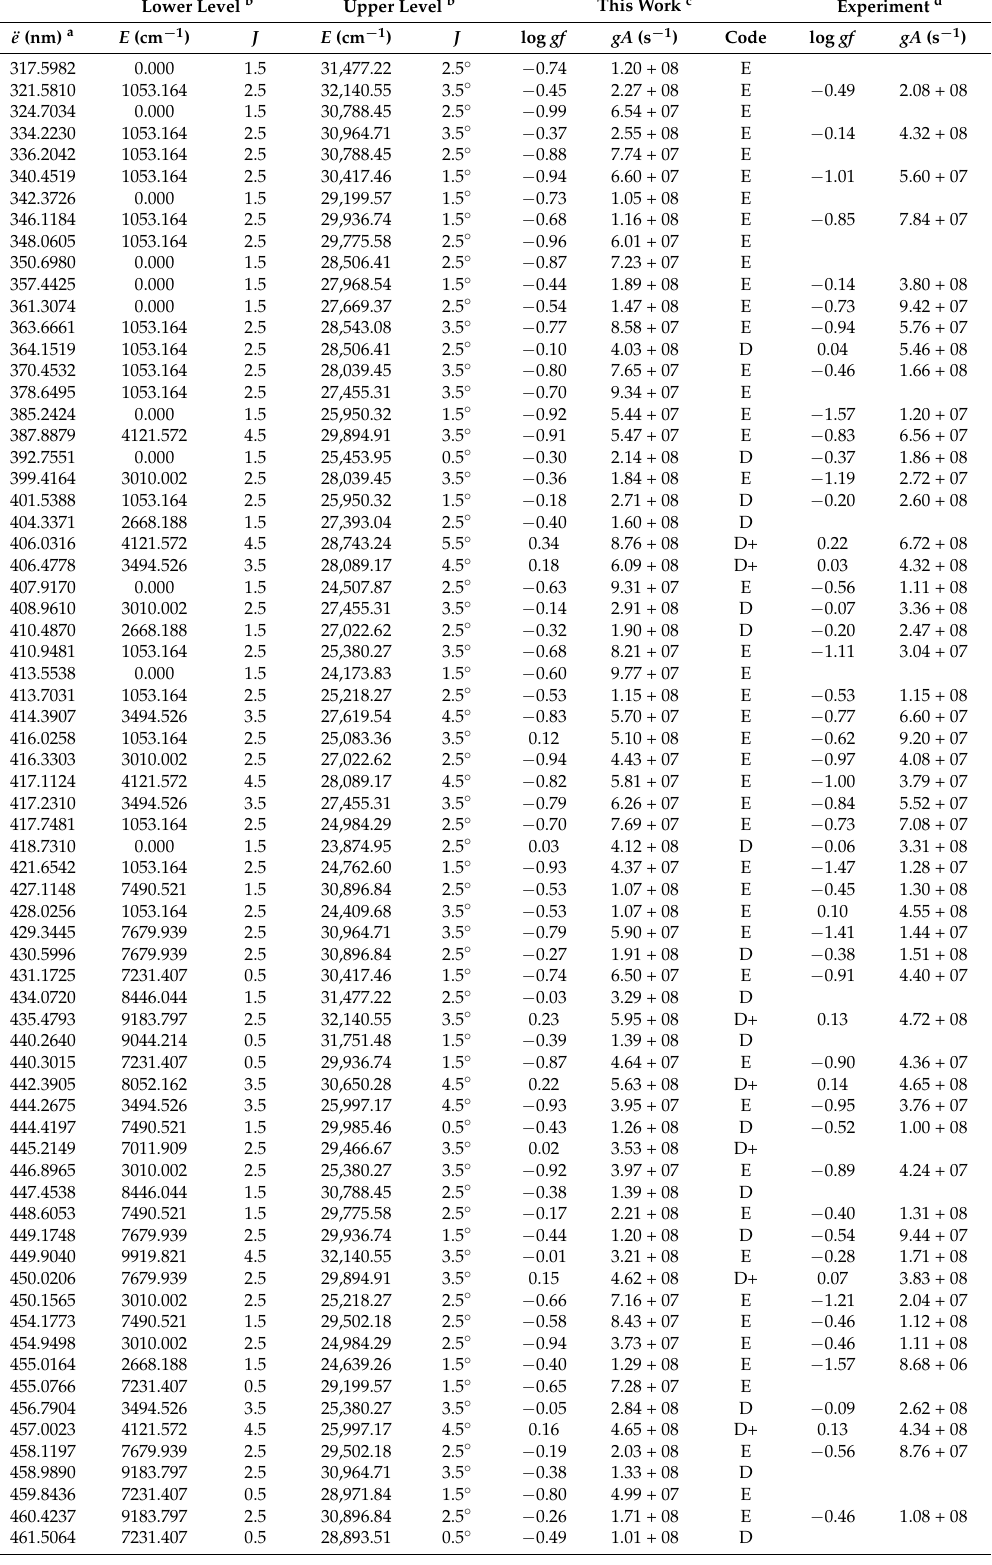
Table 2. Calculated oscillator strengths (log gf ) and transition probabilities ( gA ) for spectral lines in La I. A + B stands for A × 10 B . Experimental data are also given where available, for comparison. Lower Level b Upper Level b This Work